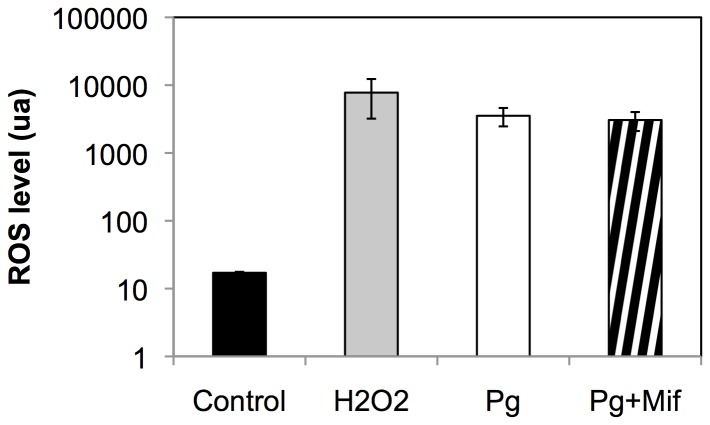
ROS levels in MCF10A cells.ROS levels were measured 40 minutes after treatment with progesterone or co-treatment with progesterone and mifepristone. As a positive control, MCF10A were treated with H2O2. Results are representative of at least three independent experiments. Error bars represent standard deviation. Asterisks denote significant differences (t-test, **p<0.01).